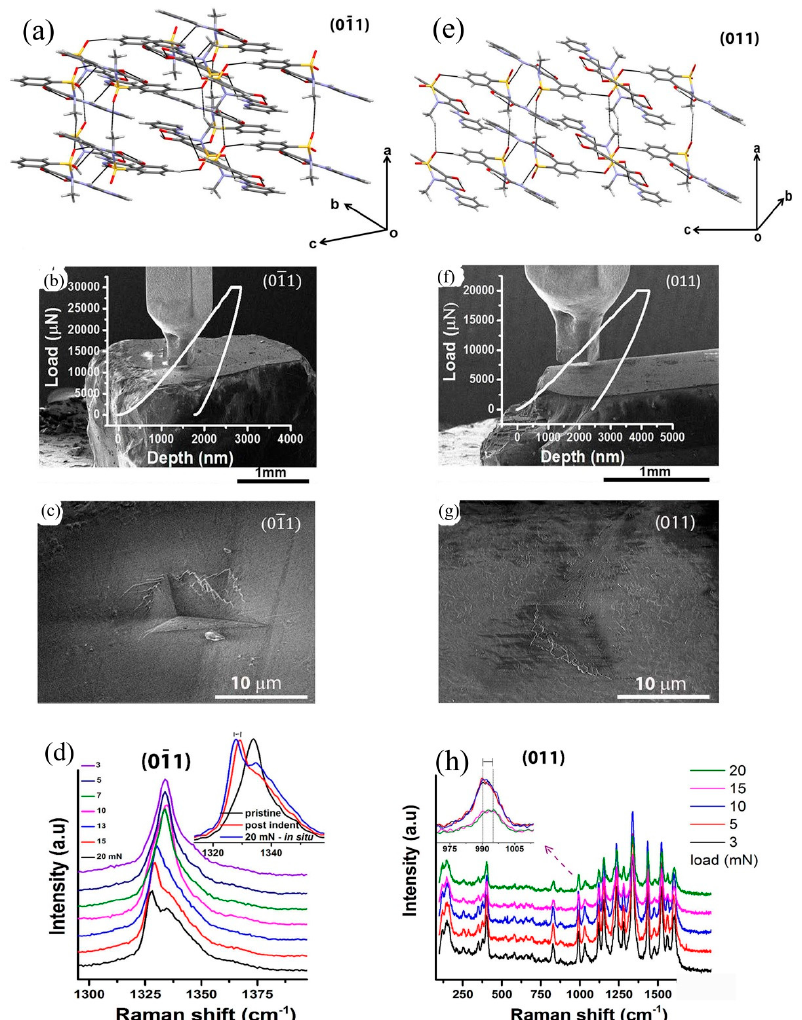
Figure 20. ( a , e ) Crystal packing of piroxicam molecules along the (011) and (011) faces. ( b , f ) In situ SEM nanoindentation on the (011) and (011) faces along with P-h responses. ( c , g ) SEM images of the residual indent impressions on the (011) and (011) indented at 30 mN load, and ( d , h ) Raman spectra obtained from the (011) and (011) faces at different loads. (Reproduced with Permission from Springer and Copyright Clearance Center, Reference 113).